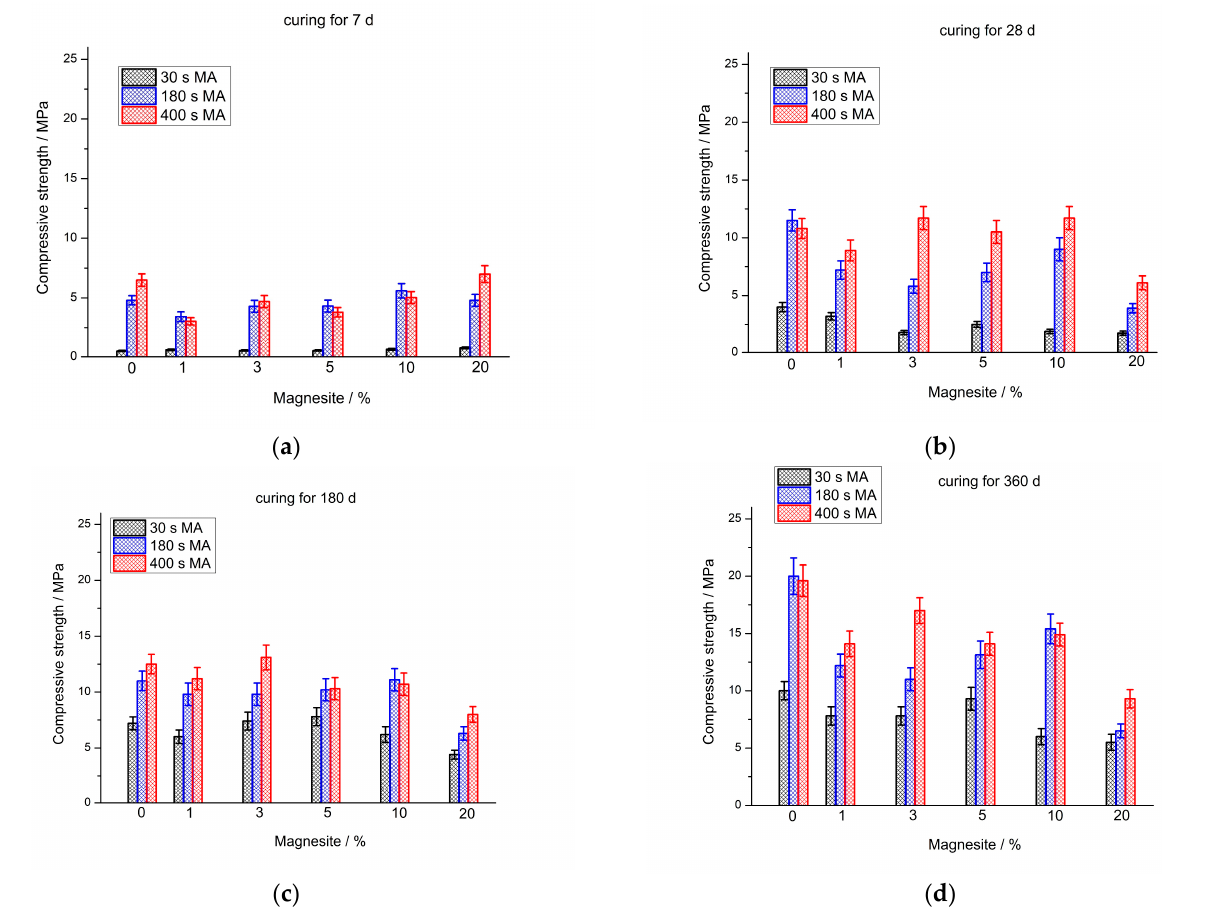
Figure 6. Effect of magnesite content and MA time on the compressive strength of geopolymers cured for: ( a ) 7 d; ( b ) 28 d; ( c ) 180 d; ( d ) 360 d.